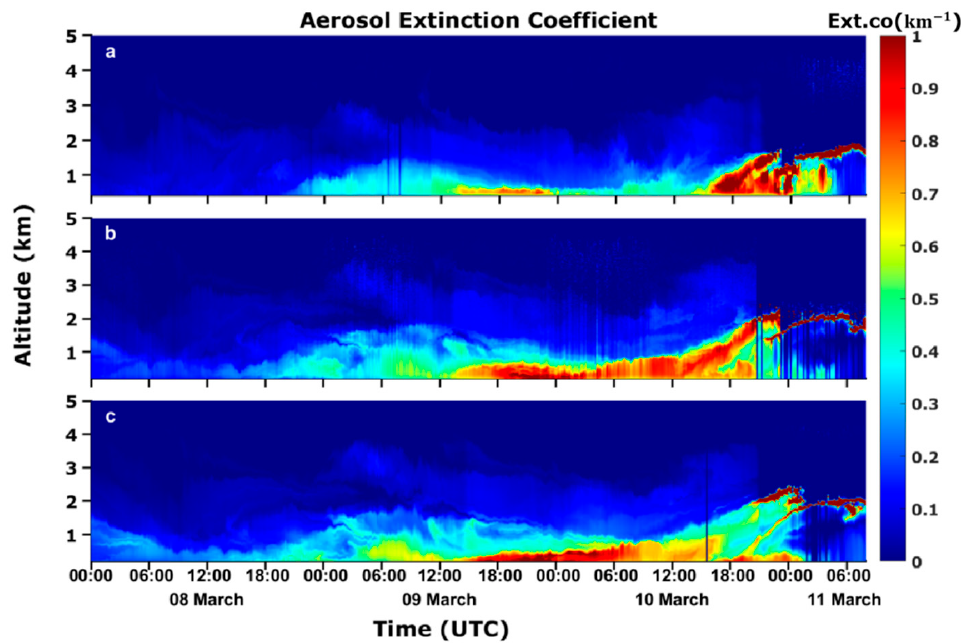
Figure 11. The spatiotemporal distribution of extinction coefficients in each region (( a ) Yanqing, ( b ) Haidian, and ( c ) Nanjiao).